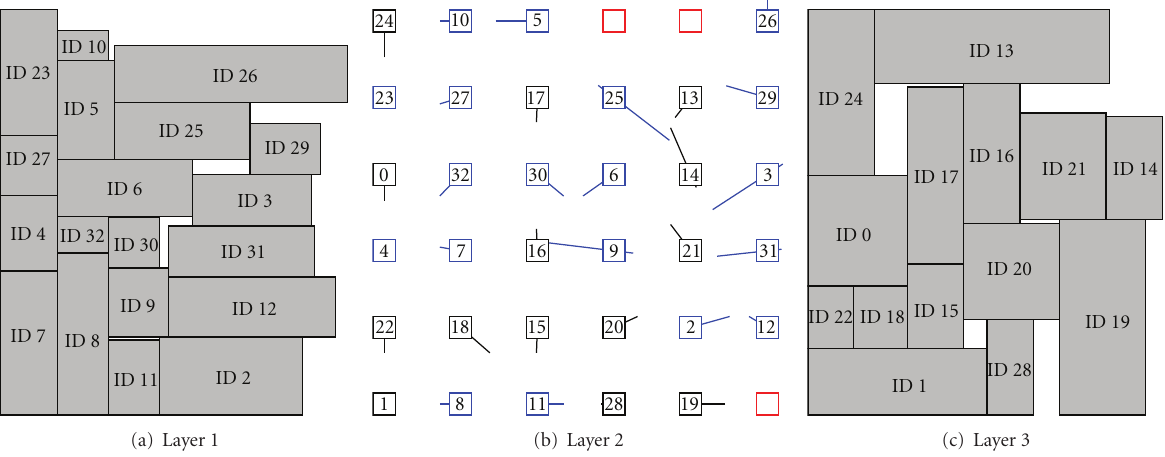
Figure 6: Floorplanning and routers assignment for ami33 using the 3-layer